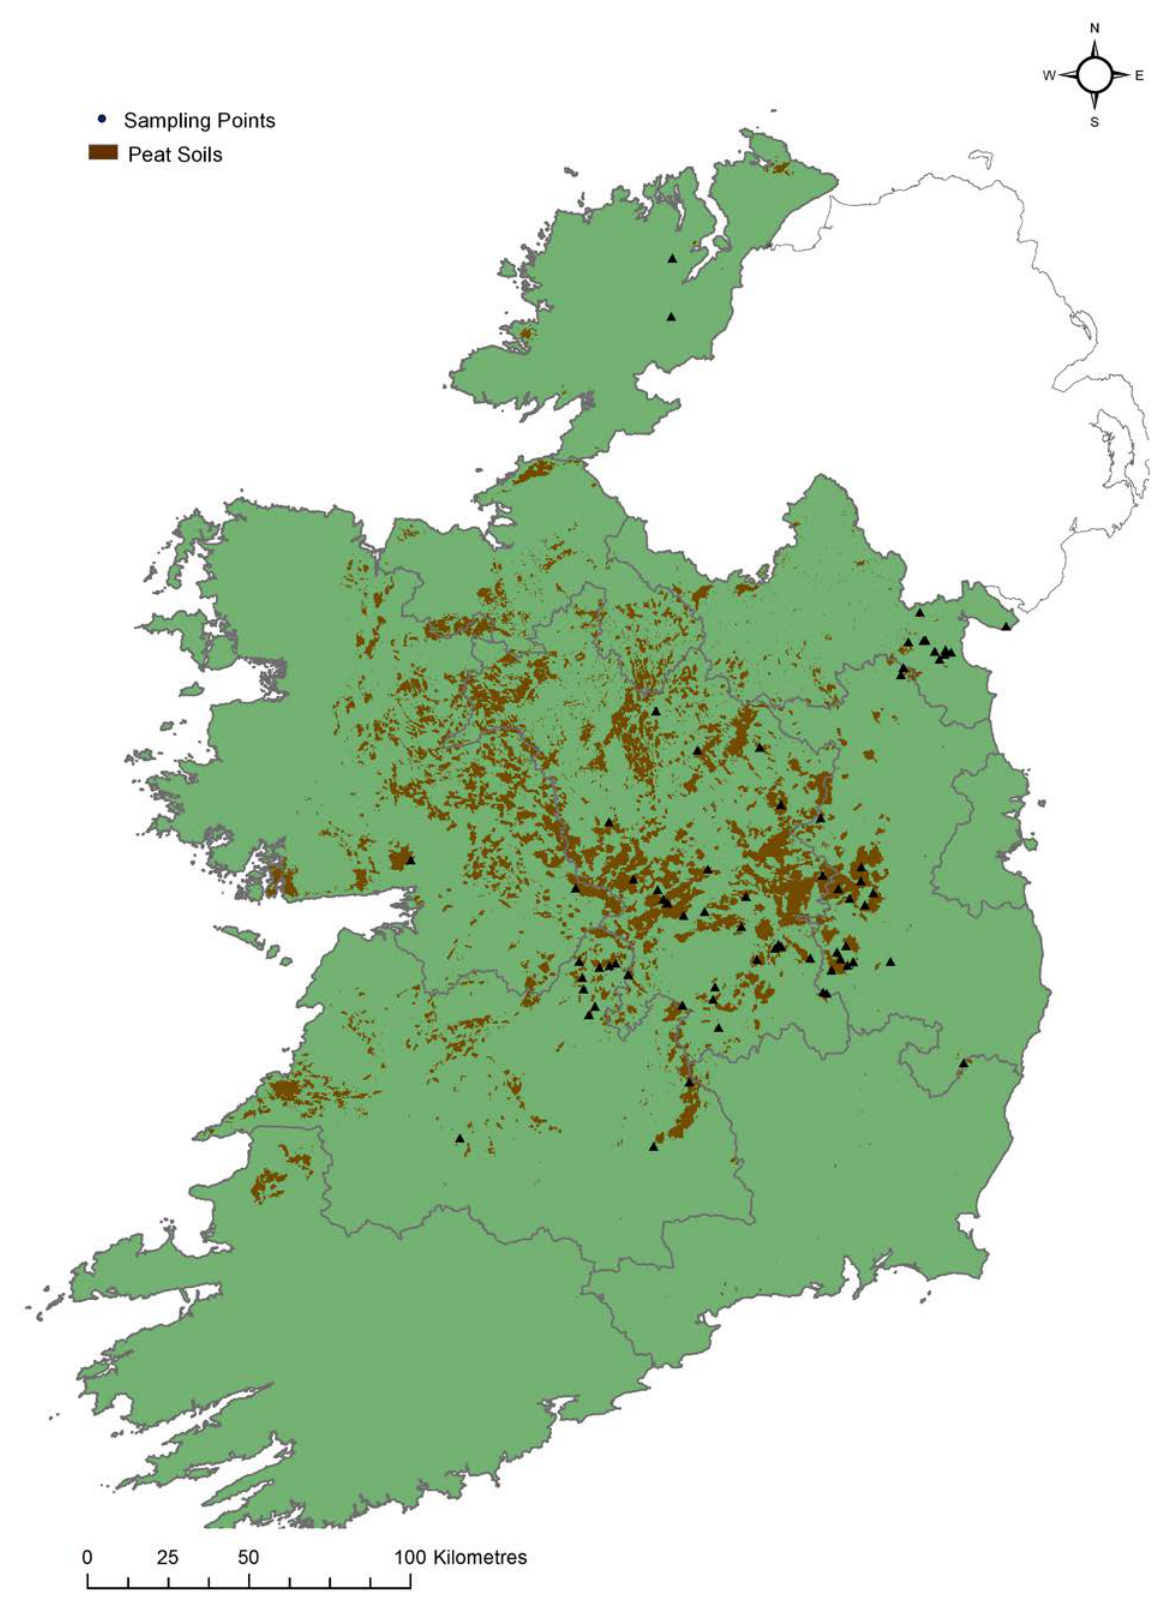
Figure 1. Map of Ireland showing the distribution of organic soils and locations of the 69 sampling points for which field sampling was